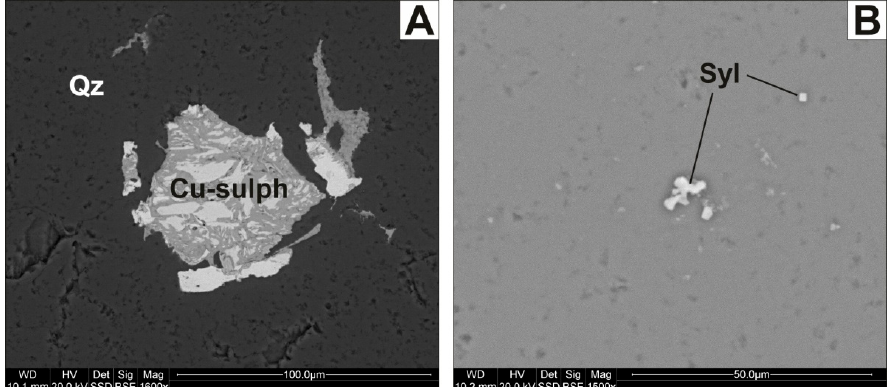
Figure 5. Back Scattered Electrons (BSE) picture of the inclusions in agates from Agouim area ( A ) Cu- compounds (Cu-sulp) in agate matrix. ( B ) Small inclusions of sylvite (Syl) in agate matrix.